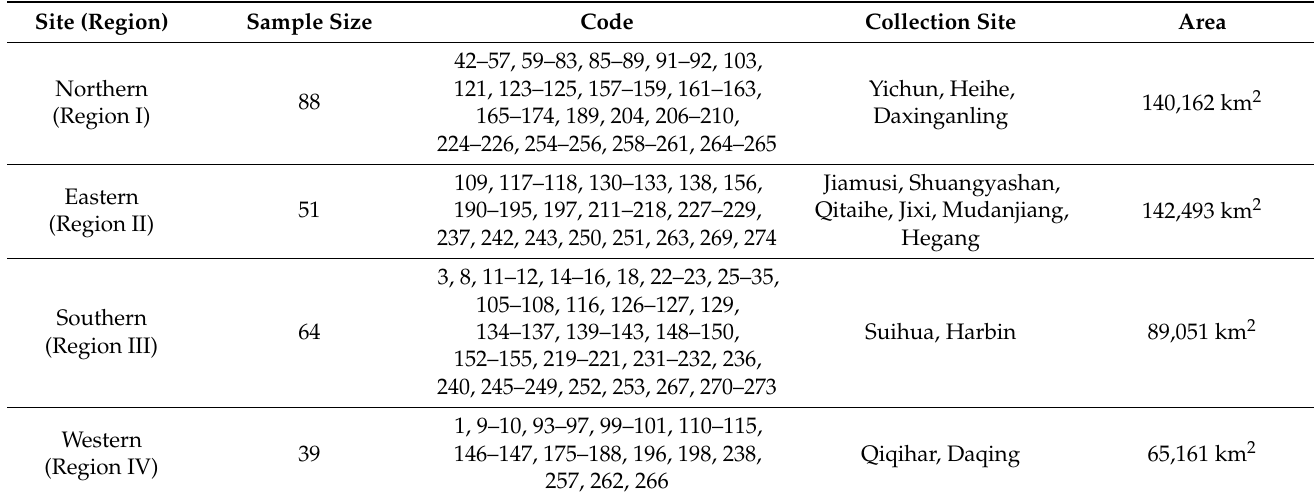
Table 1. Collecting sites of 242 wild soybean samples analyzed in this